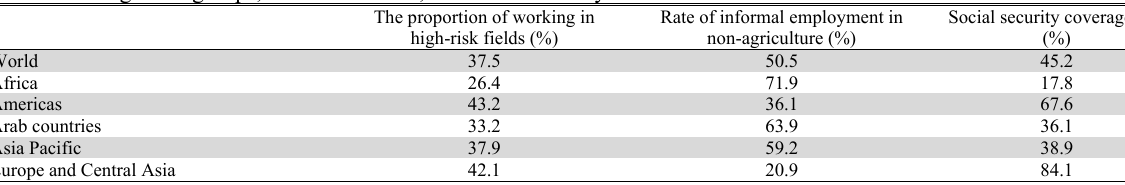
Workers in high-risk groups, unofficial status, and social security